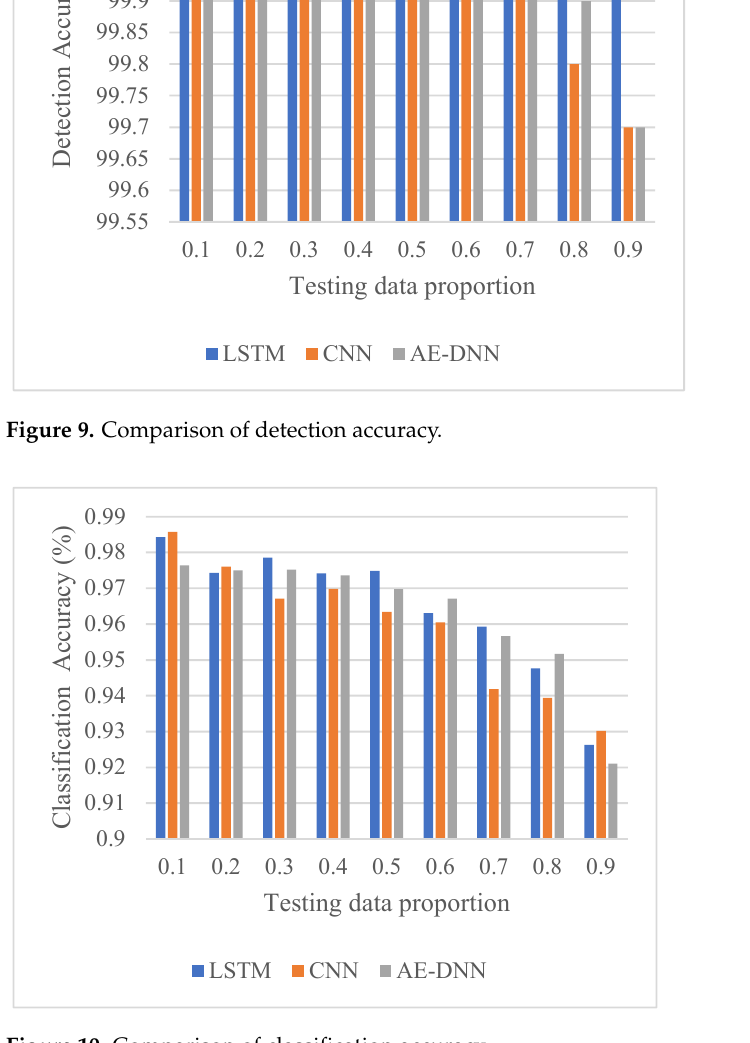
Figure 10. Comparison of classification accuracy.